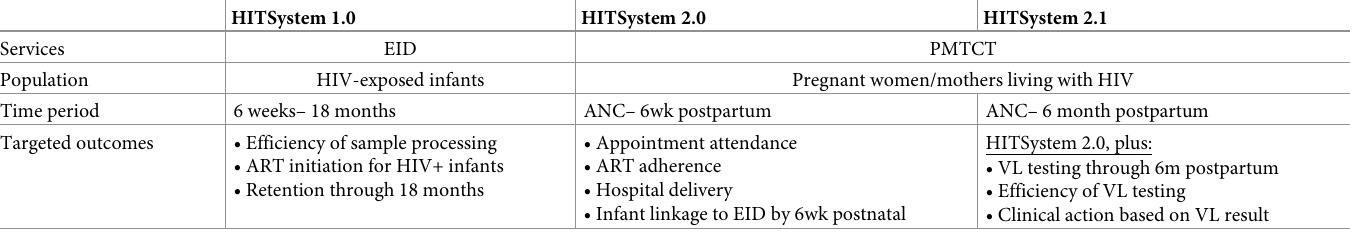
Table 1. Key difference between iterations of the